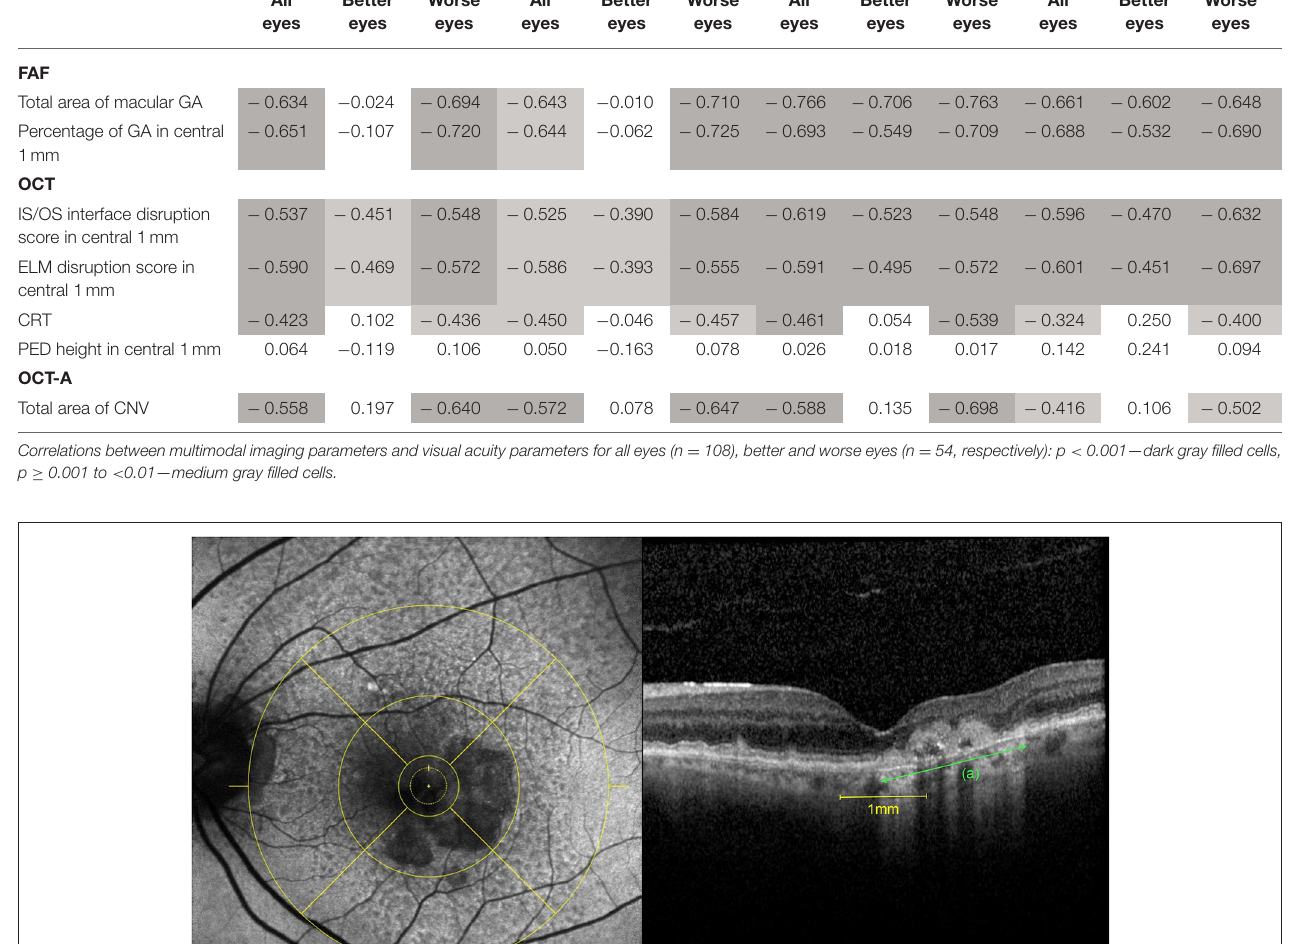
BCVA (ETDRS letters) LLVA (ETDRS letters) CS (log units) MRS monocular (wpm) All Better Worse All Better Worse All Better Worse All Better Worse eyes eyes eyes eyes eyes eyes eyes eyes eyes eyes eyes eyes